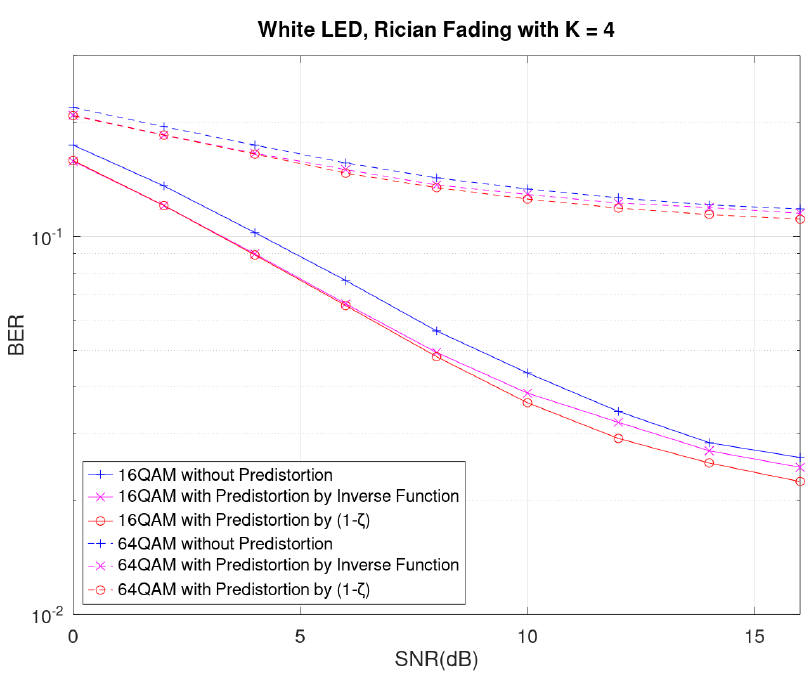
Figure 10. BER performances with Rician fading, K = 4 in 16/64 QAM modulation for white LED.